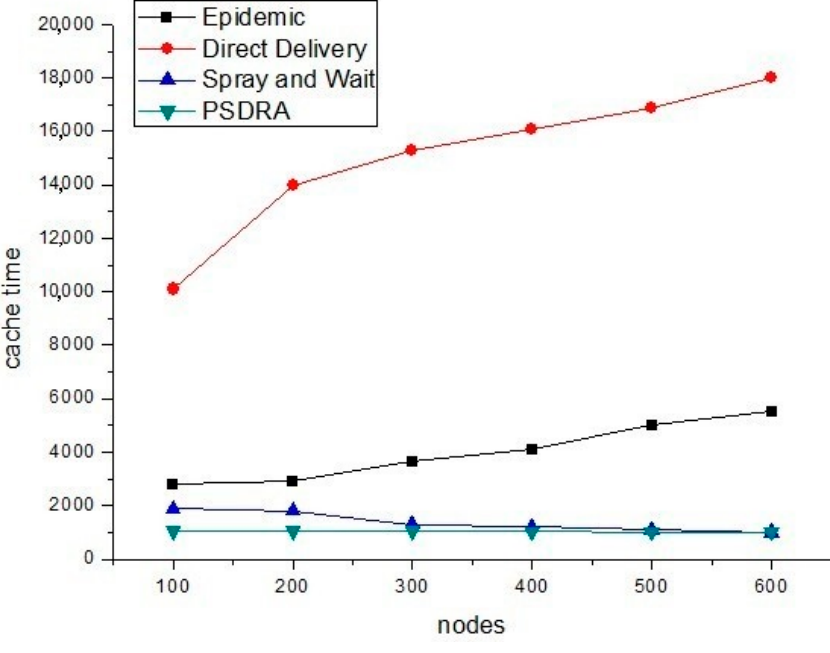
Figure 3. The cache time with algorithm.